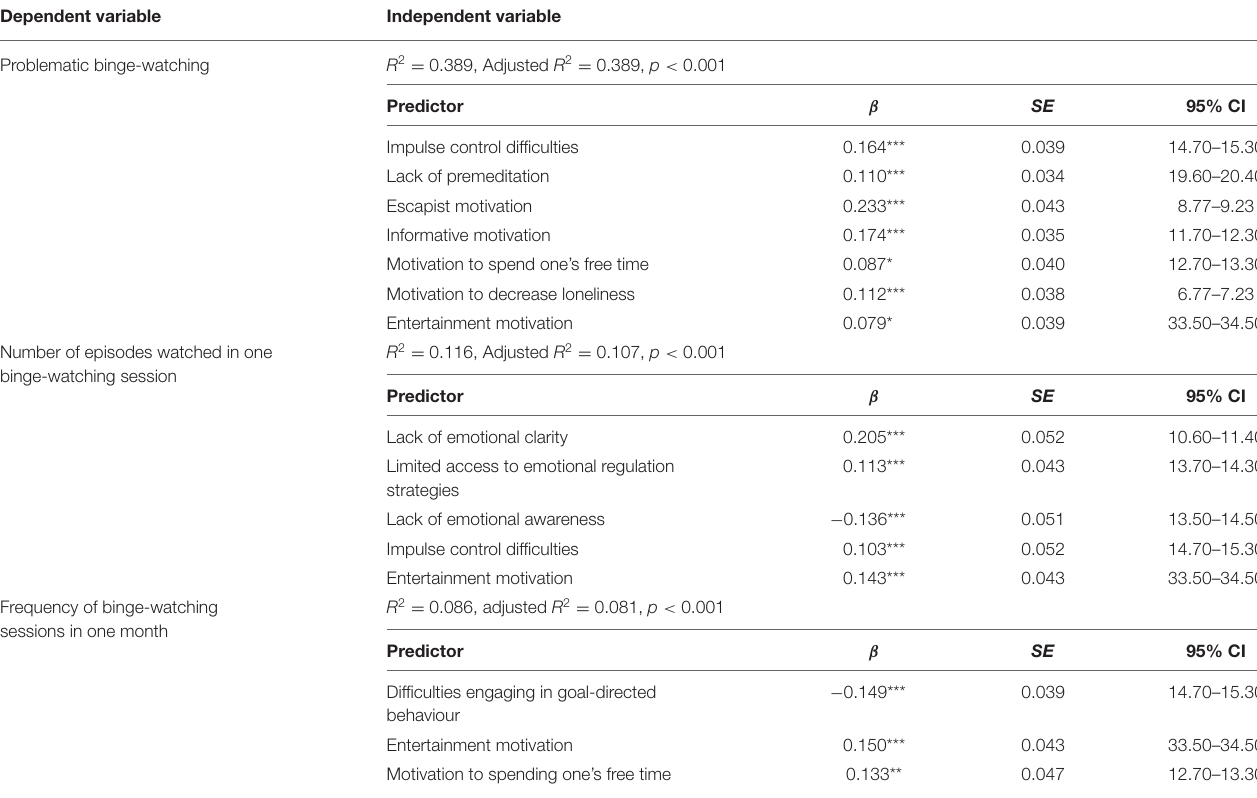
TABLE 3 | Psychological predictors of problematic binge-watching. Dependent